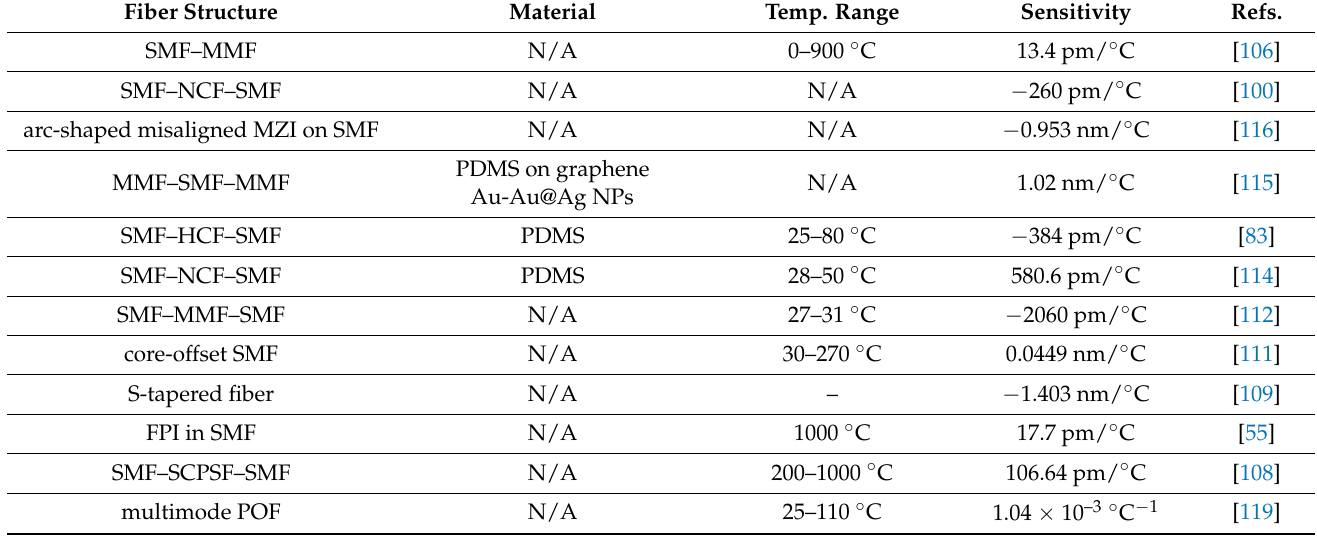
Table 2. Summary of other conventional optical fiber-based temperature